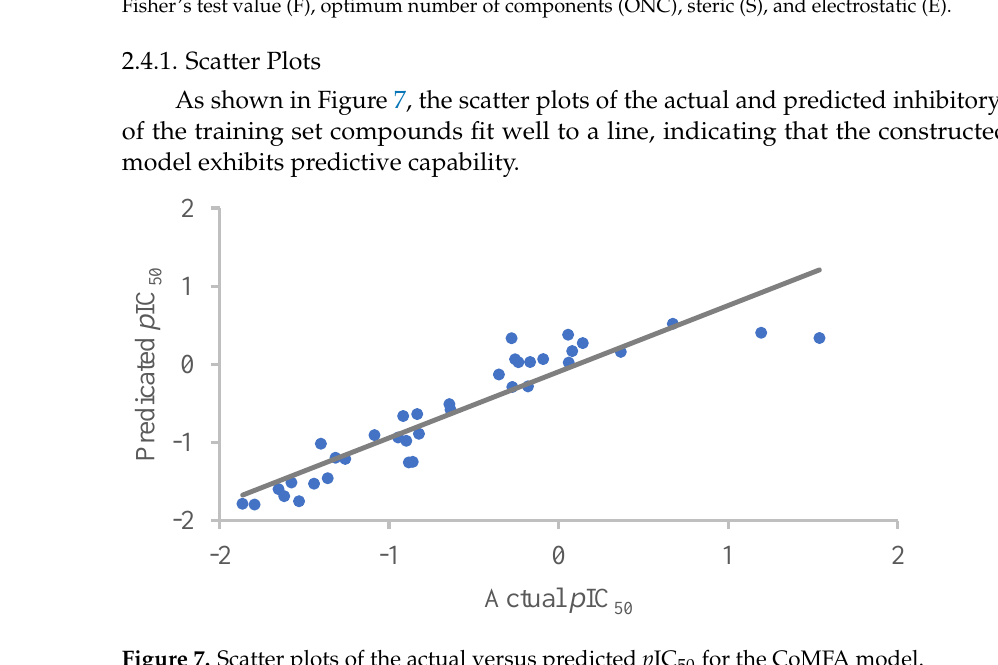
Table 3. Statistical result of the CoMFA model.